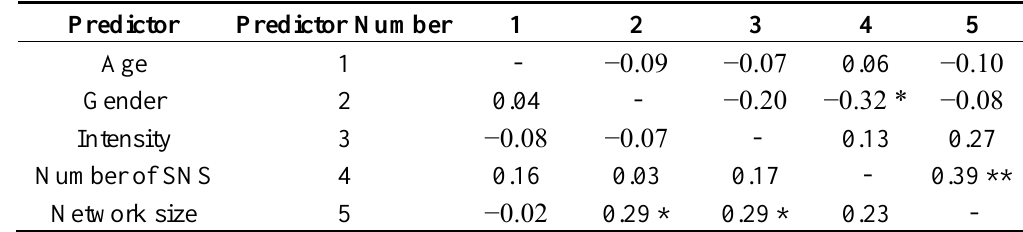
Table 3. Intercorrelations for predictors and logged Orkut network size. Upper half matrix refers to non-migrant users; lower half matrix to migrant users.